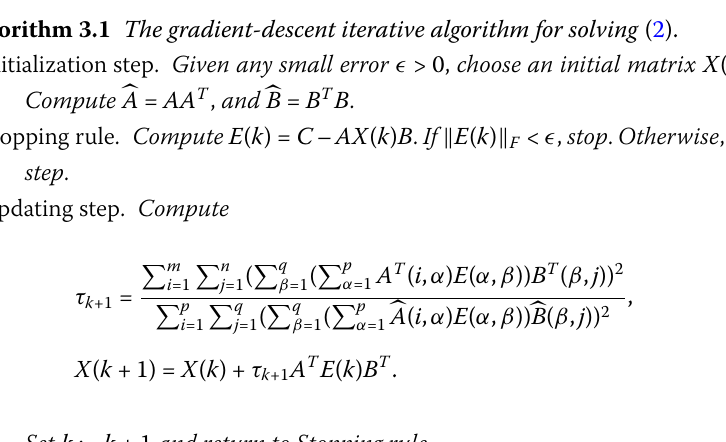
Algorithm 3.1 The gradient-descent iterative algorithm for solving